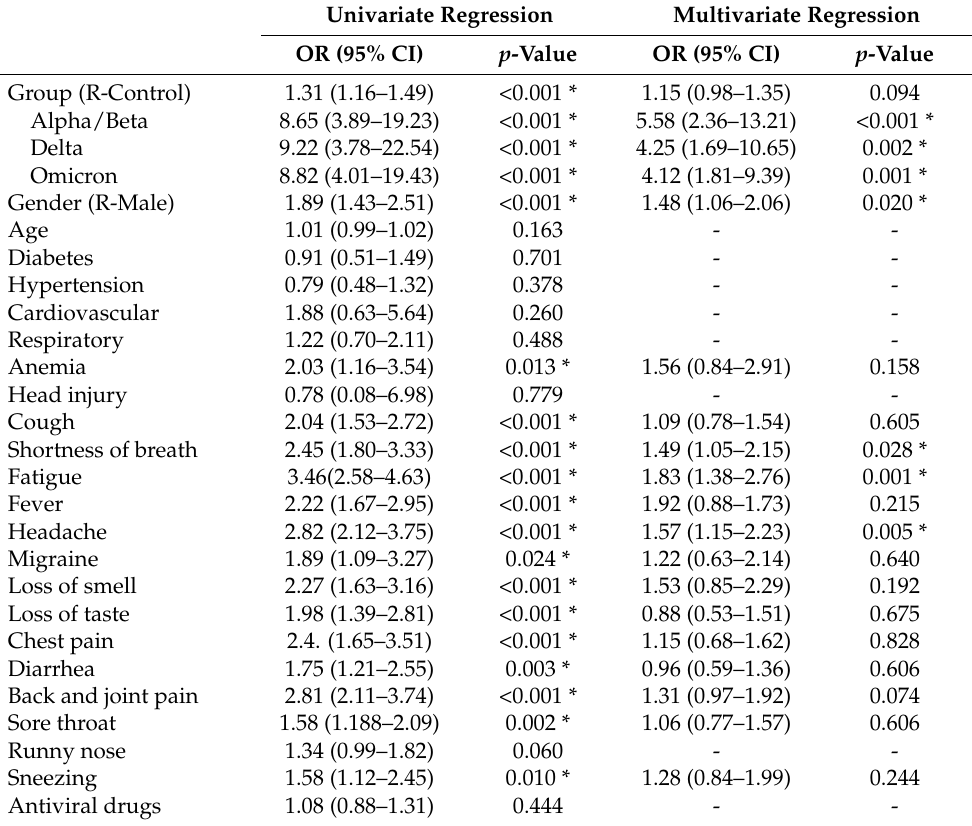
Table 4. Univariate and multivariate binary logistic regression for vestibular symptoms (unsteadiness, dizziness, and vertigo). Univariate